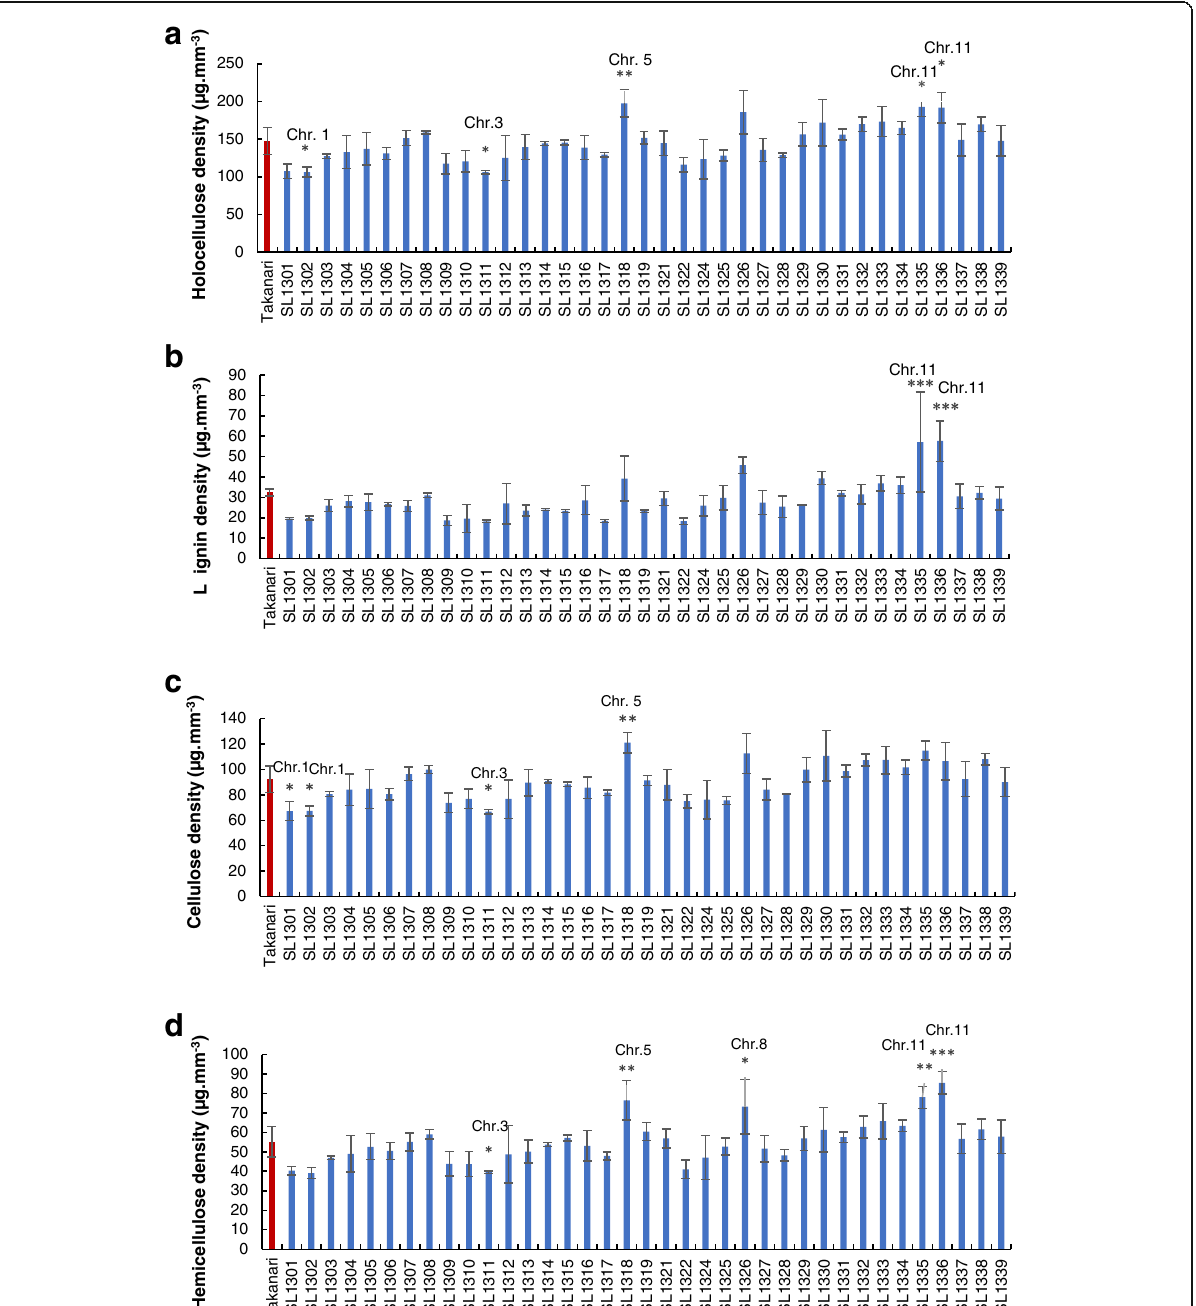
Fig. 3 Cell wall material density of the fourth internode in 2015. a holocellulose, b lignin, c cellulose, and d hemicellulose. Data are expressed as the mean ± SD. *, **, and *** represent significant differences at 5%, 1, and 0.1% level,